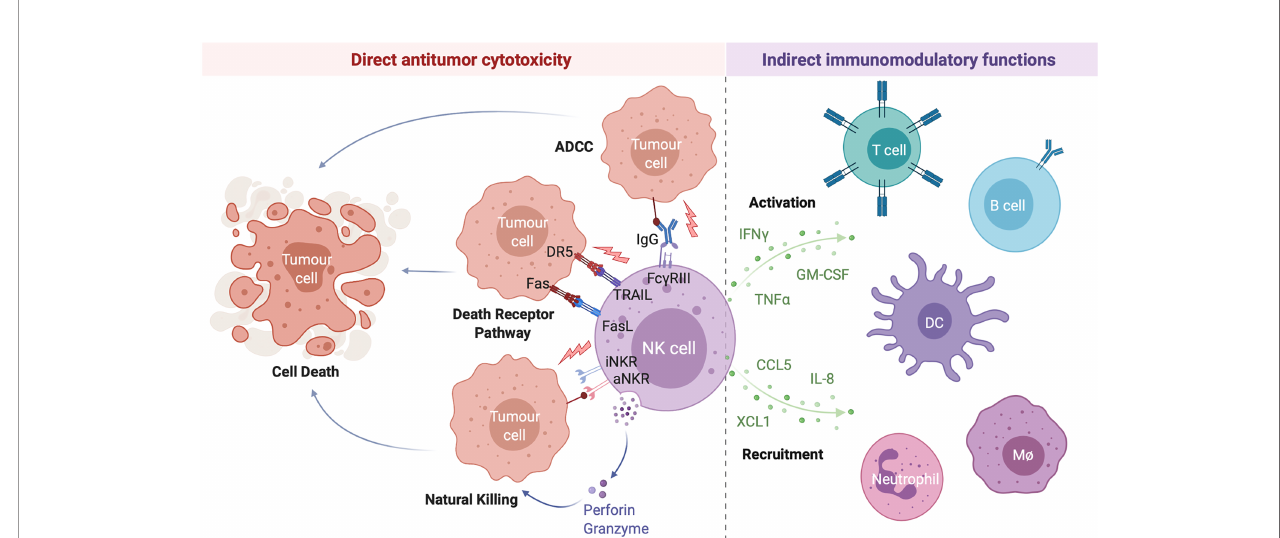
FIGURE 1 | NK Cells Exert a Range of Direct and Indirect Antitumor Effects. NK cell activation is governed by the net balance between signals received through various activating and inhibitory NK cell receptors. When the balance is tipped towards activation, NK cells can directly lyse target cells through release of the preformed cytotoxic granules granzyme B and perforin (natural killing) or by the engagement of target cell death receptors by NK cell-expressed death receptor ligands TRAIL and FasL (death receptor pathway). Antibody opsonized target cells may also be directly lysed through engagement of the NK cell IgG Fc region receptor III (Fc g RIII; CD16) in a process of antibody dependent cell-mediated cytotoxicity (ADCC). Activated NK cells are also potent producers of immunomodulatory cytokines (such as interferon gamma (IFN g ), tumor necrosis factor alpha (TNF a ), and granulocyte-macrophage colony-stimulating factor (GM-CSF)) and chemokines (including interleukin-8 (IL-8), CCL5, and XCL1) which activate and recruit other immune cells to the tumor microenvironment, indirectly driving a multifaceted antitumor response. Created with